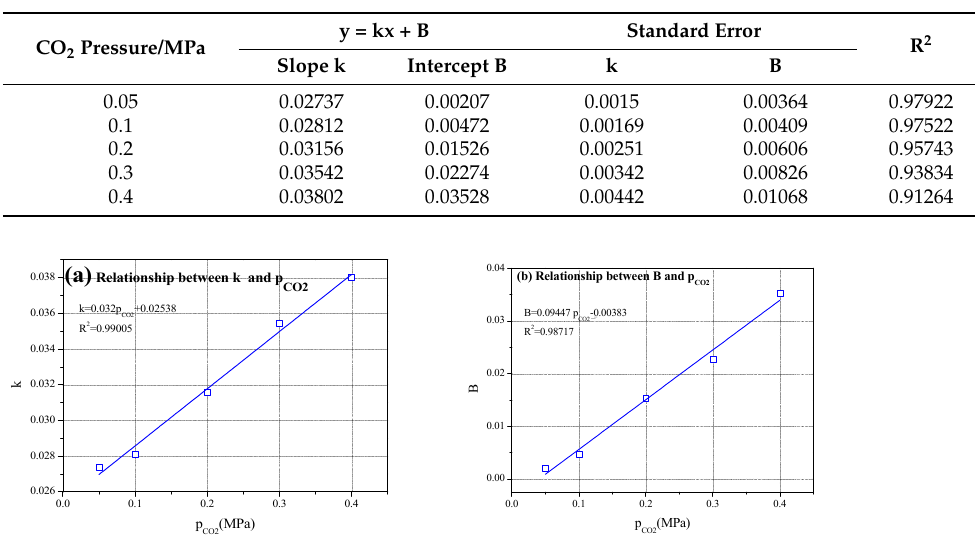
Figure 6. Relationships between k and B with CO 2 pressure.